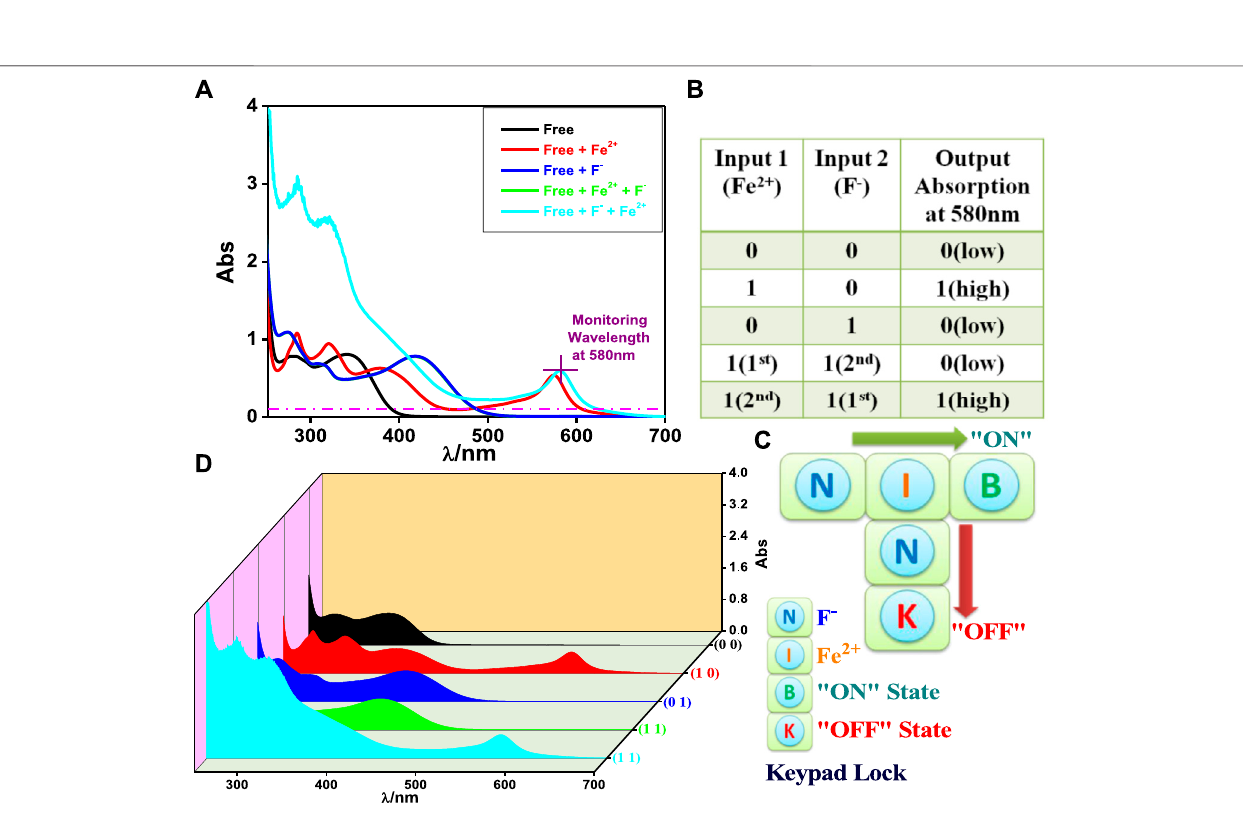
Frontiers in Chemistry |